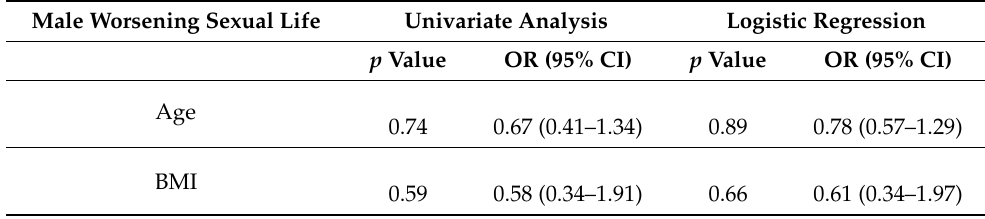
Table 6. Univariate analysis and multivariate logistic regression final model for male worsened sex lives vs. demographic and psychological